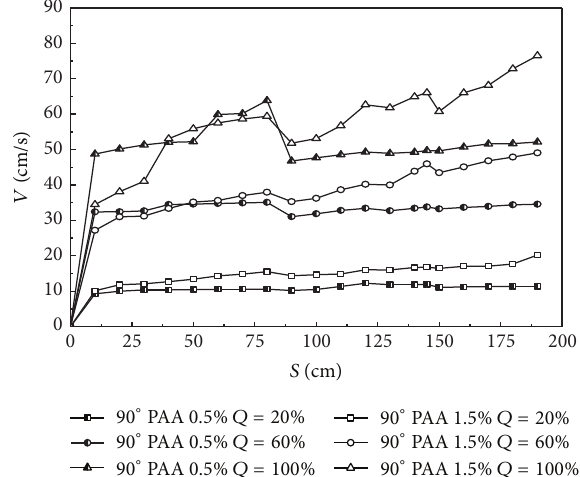
Figure 7: The PAA velocity-position diagram of various flow in 90 ∘ curved